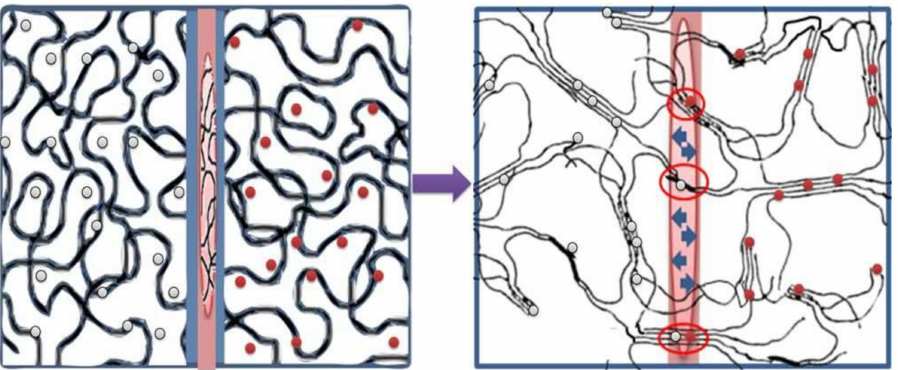
Figure 15. Scheme of bilayer synthesis cryogels. Republished with permission from [82]. Copyright 2018